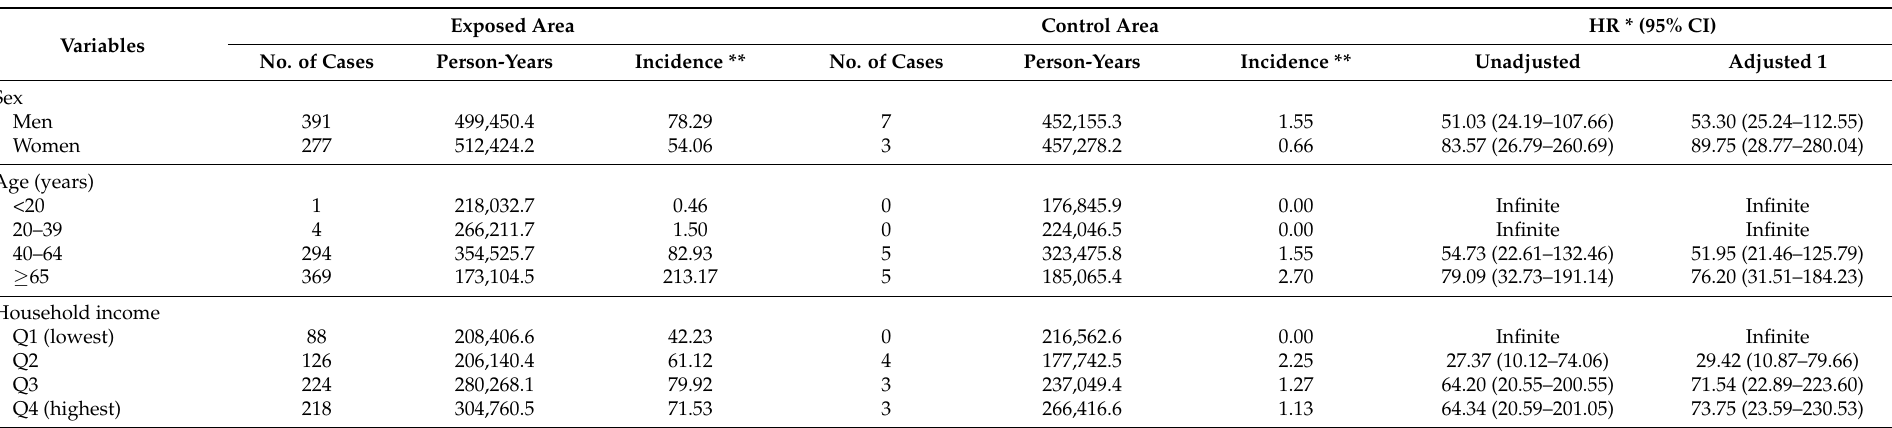
Table 4. Incidence rates and hazard ratios of asbestosis stratified by sex, age, and household income.